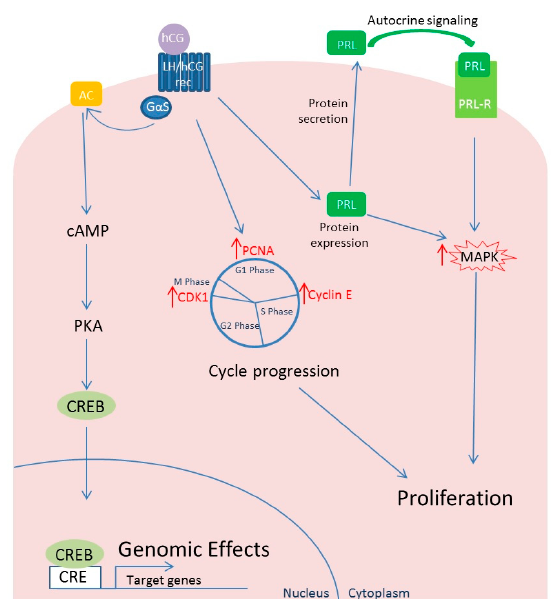
Figure 2. hCG signaling and effects on leiomyomal cells. In human myometrial smooth muscle and leiomyomas cells, hCG: (I) activates the cAMP/PKA signaling pathway causing changes in the expression of several target genes mediated by related transcription factors such as CREB; (II) promotes cell cycle, increasing expressions of key proteins like PCNA, cyclin E and cdc2; and (III) promotes production of prolactin that, directly and through autocrine/paracrine effect, increases cell proliferation. The signaling pathways regulating cell cycle progression genes in leiomyomal cells have not been clarified yet. hCG: human Chorionic Gonadotropin; LH: luteinizing hormone; LH/hCG rec: LH/hCG receptor; AC: Adenylate cyclase; PKA: protein kinase A; CREB: cAMP Responsive Element Binding Protein; CRE: cAMP Responsive Element; PCNA: Proliferating cell nuclear antigen; CDK1: cyclin-dependent kinase 1; PRL: Prolactin; PRL-R: Prolactin Receptor; the red arrows represent increased expression.